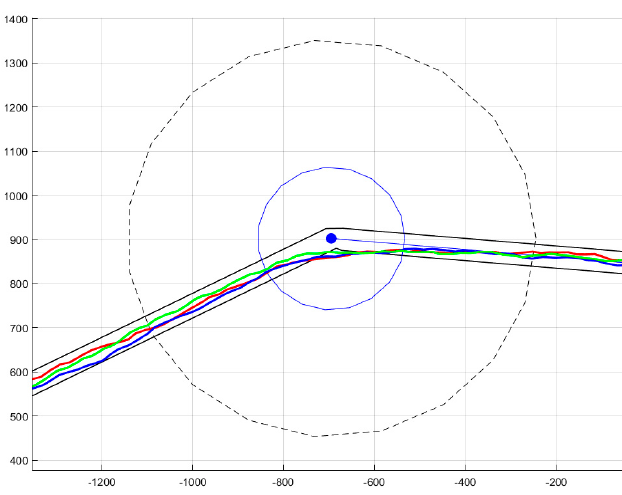
Figure 8. Illustration of trajectory tracking for multiple runs and with bounding corridor.